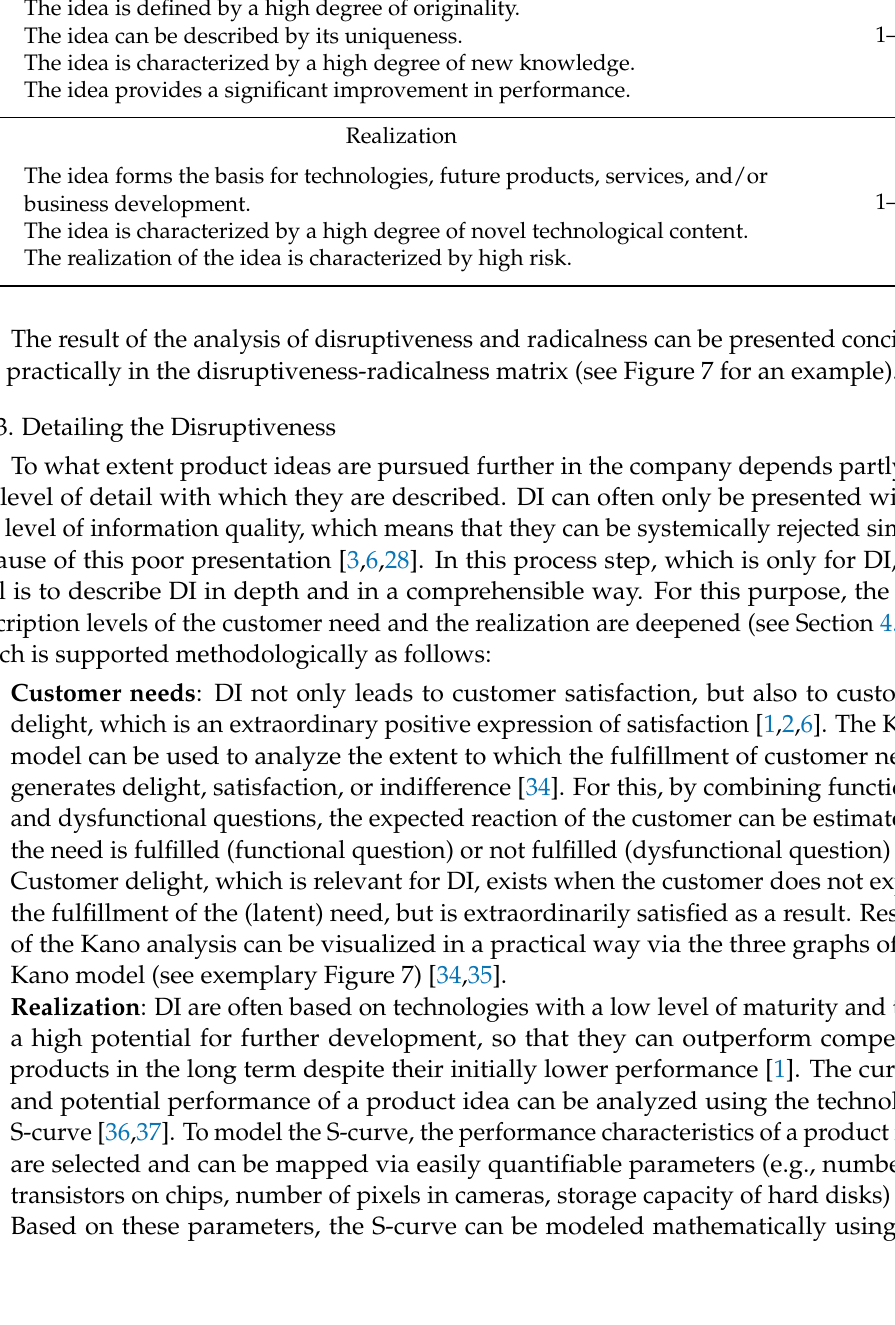
1–5 • The idea allows customers to do things they could not do